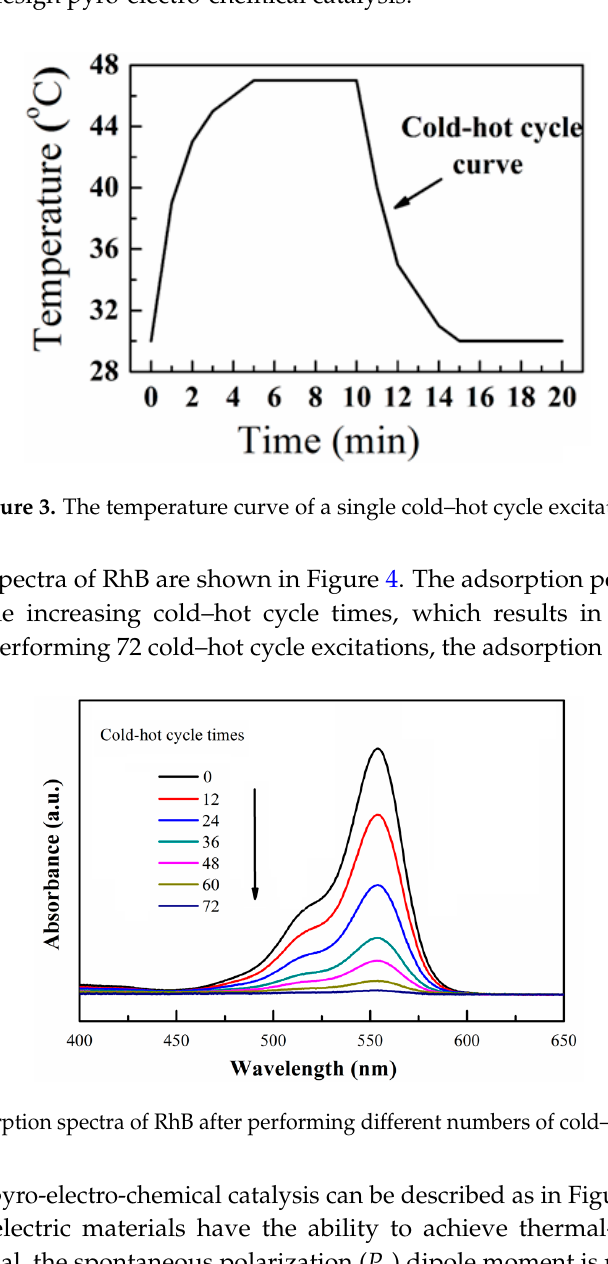
Figure 3. The temperature curve of a single cold–hot cycle excitation.